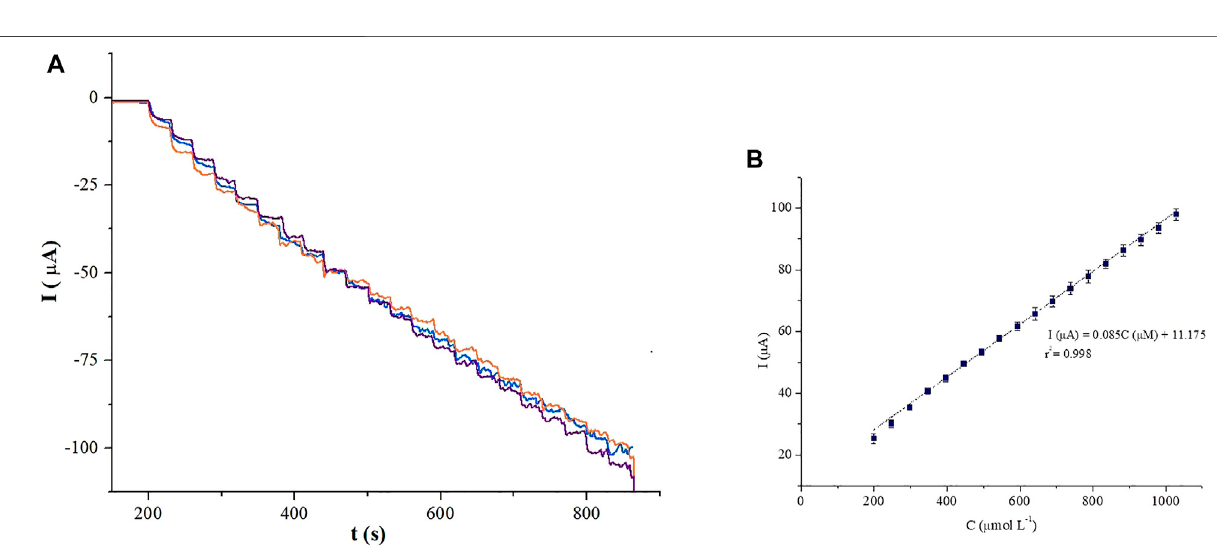
Frontiers in Chemistry |